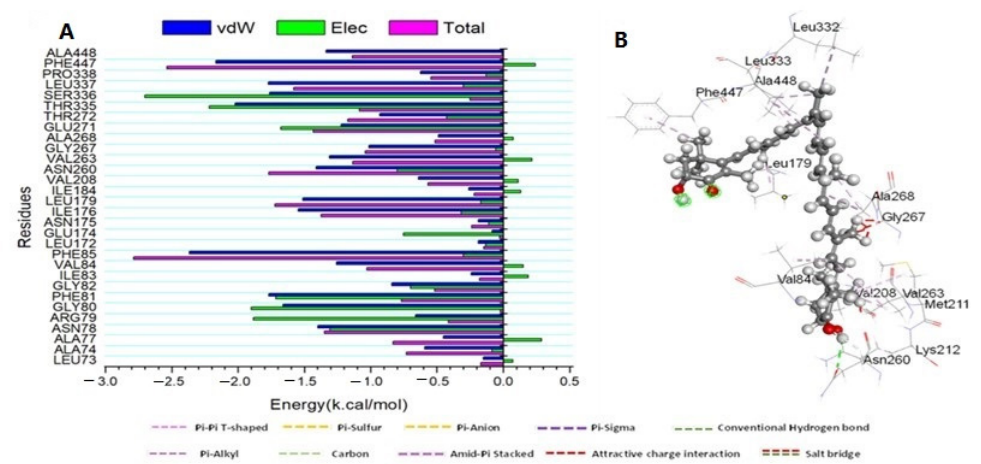
Figure 6. ( A ) Per-residue decomposition plots showing the energy contributions to the binding and stabilization of the Astaxanthin at the catalytic active site of human cytochrome P450 CYP2C9 protein receptor; ( B ) Corresponding inter-molecular interaction of the Astaxanthin to the catalytic active site of human cytochrome P450 CYP2C9 protein receptor.